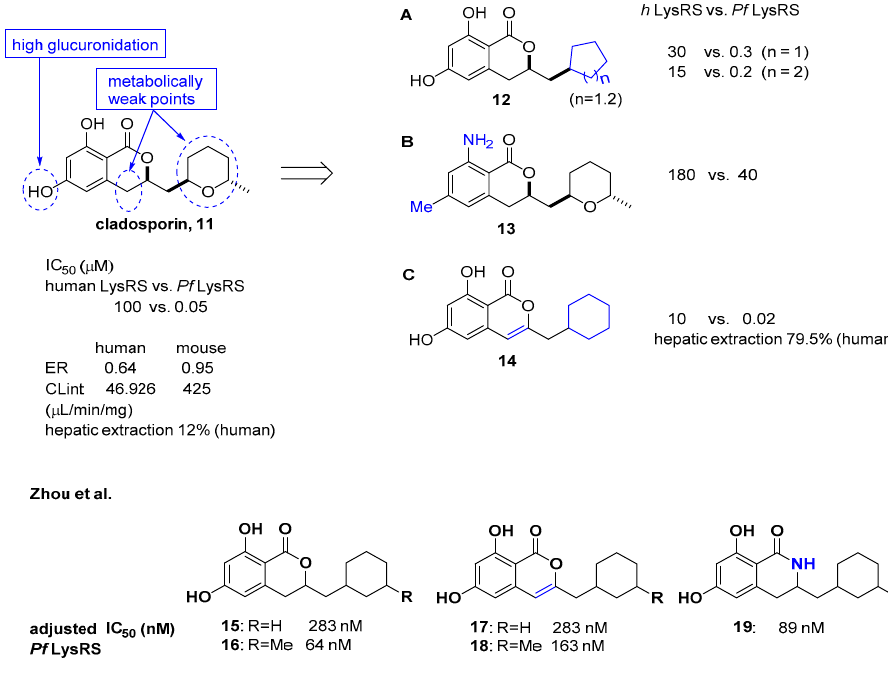
Figure 5. Optimization of cladosporin to improve pharmacokinetic properties [26,28].